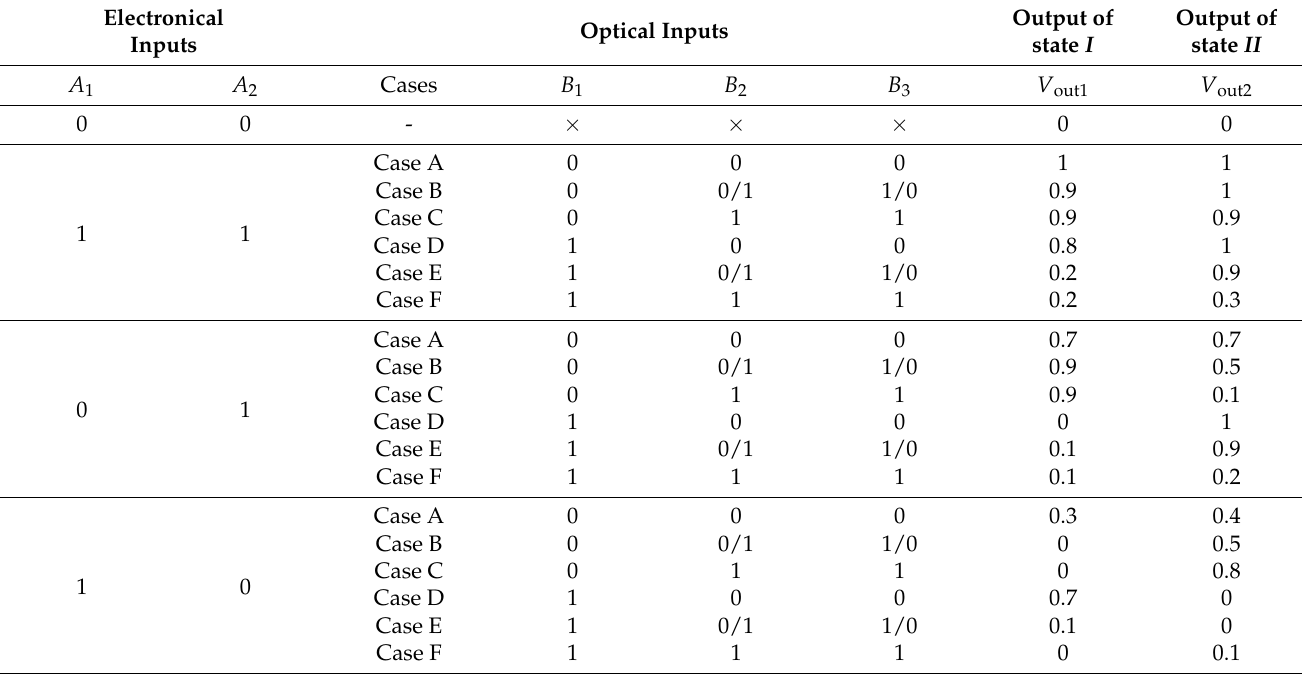
Table 4. Truth table of multi-valued logic